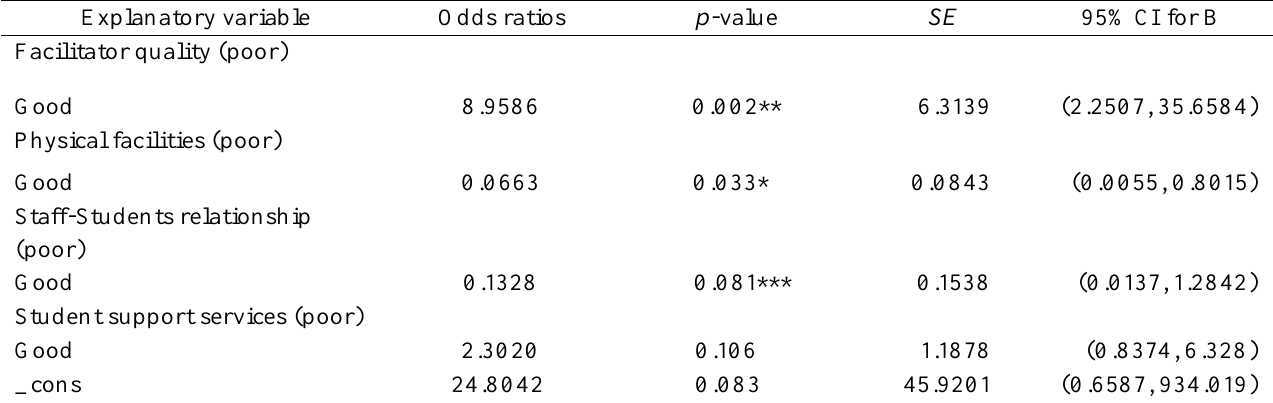
Logistic Regression Results of the Determinants of Postgraduate Students’ Satisfaction Explanatory variable Odds